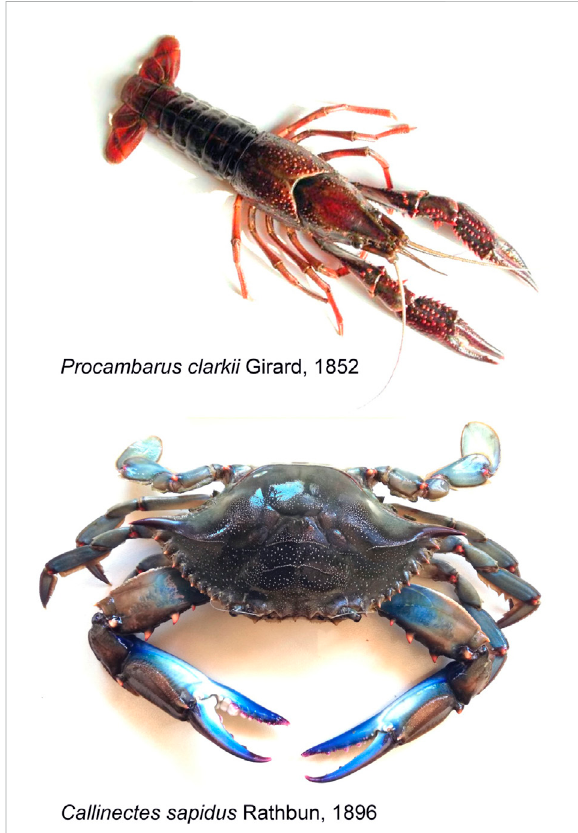
FIGURE 1 Photographs of Procambarus clarkii (upper side) and Callinectes sapidus (lower side), the two model crustaceans used for the validation of the LifeWatch ERIC case study on trophic habits of omnivorous invasive species. Note that the two photos are not in